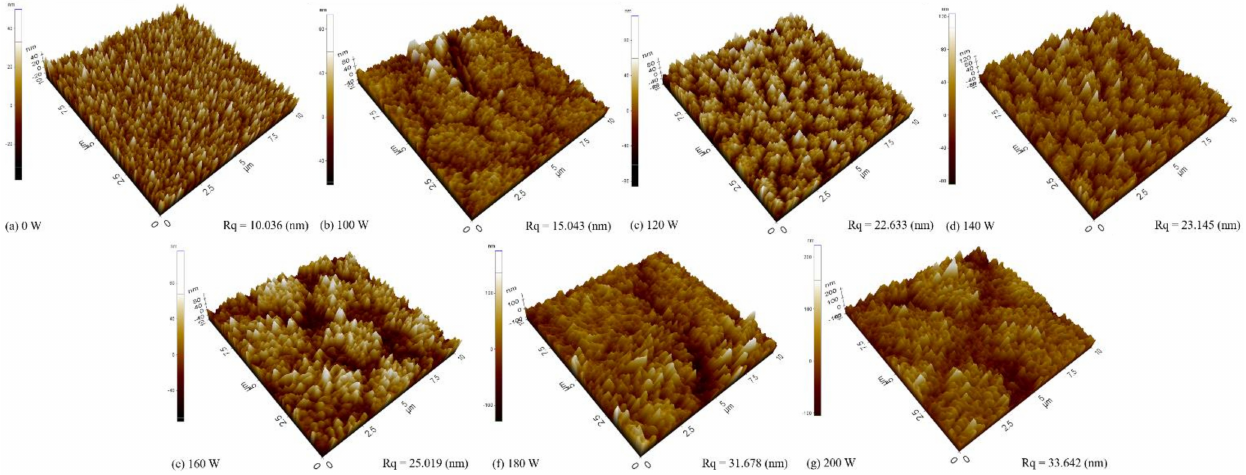
Figure 4. AFM images of perovskite films composed of MAPbI 3 and CsPbI 3 QDs treated at different argon plasma powers, from ( a – g ) 0–200 W.